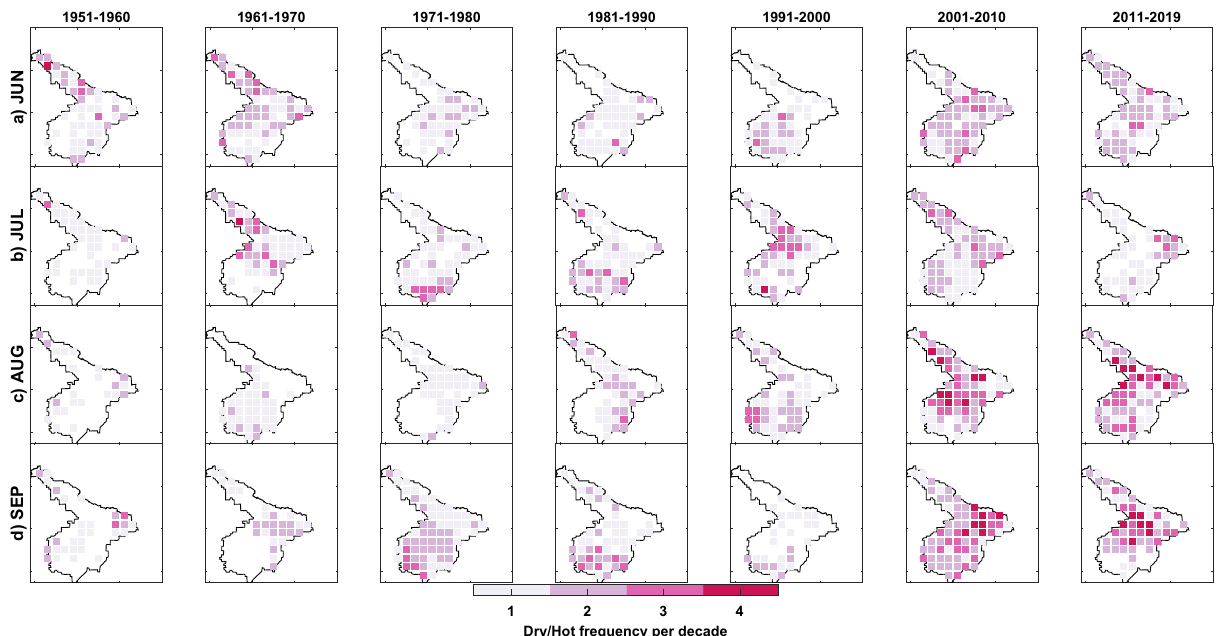
Figure 5. Geographical representation of spatial extent over homogenous North-Central region during ( a ) June, ( b ) July, ( c ) August and ( d ) September at decadal time scale. Colorbar represents the number of